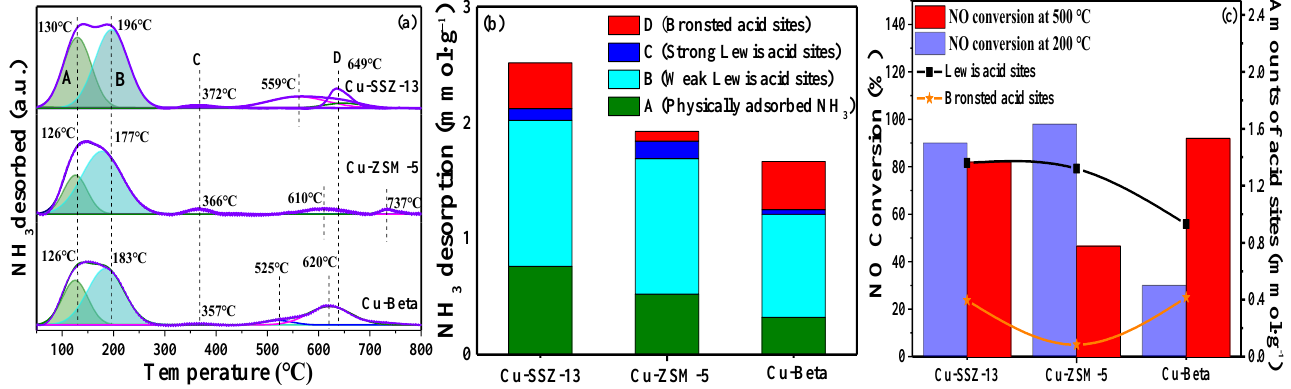
Figure 10. NH 3 -TPD patterns ( a ), amount of NH 3 desorption ( b ) and relationship between acid sites and catalytic activity ( c ) for the copper-based zeolites.